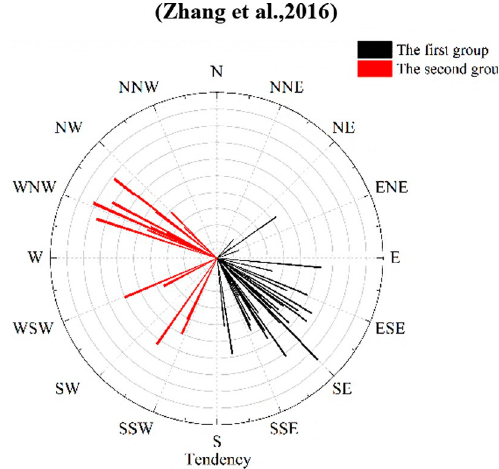
Fig. 2 Pole diagram of the measured fractures